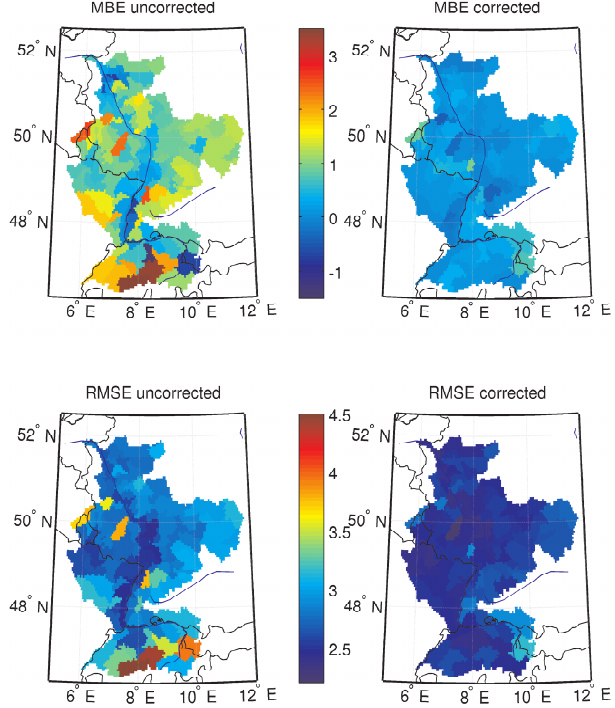
Fig. 16. Top: MBE for the uncorrected and corrected ERA15/REMO temperature [ ◦ C] per sub-basin for the validation period 1989–1995. Bottom: RMSE for the uncorrected and cor- rected ERA15/REMO temperature [ ◦ C] per sub-basin for the vali- dation period 1989–1995.